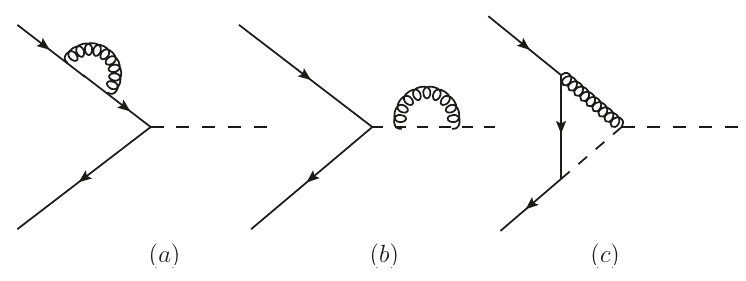
Figure 5 . The virtual corrections to the resonant leptoquark production at O ( α s )